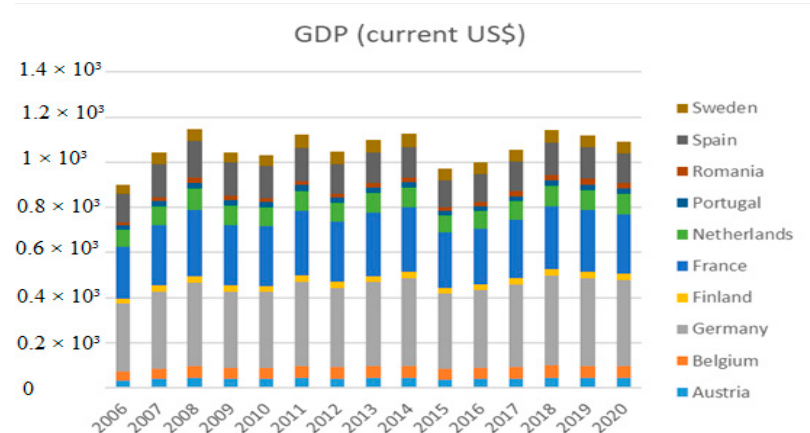
Figure 1. Data for Figure 1. Data for GDP.